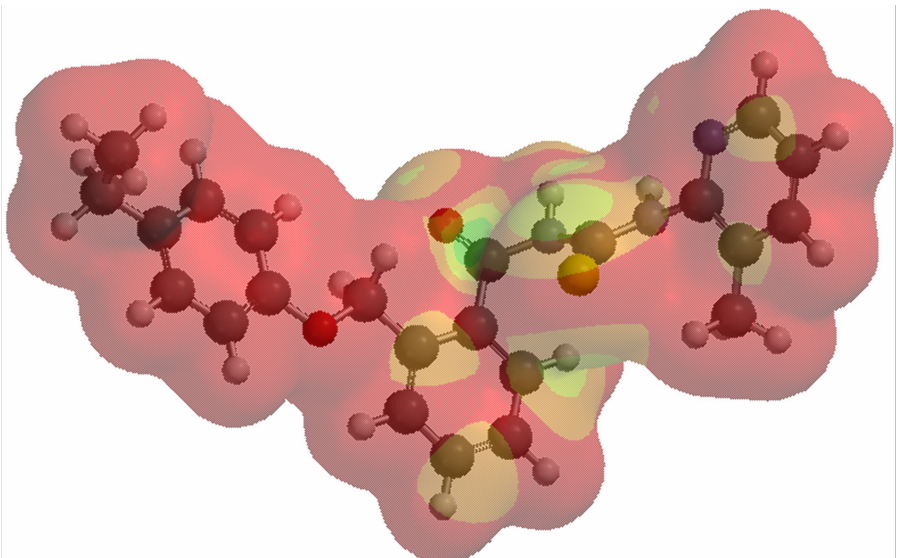
Figure 4. LUMO map for compound 1d . The red color or shades of red represent the minimum value of the LUMO (absolute values near zero), and the blue color is used for indicating the maximum absolute values. Supporting information with respect to the LUMO map representation for every chemical compound included in the current study is provided in the Supplementary Materials, Figure S3a–o.